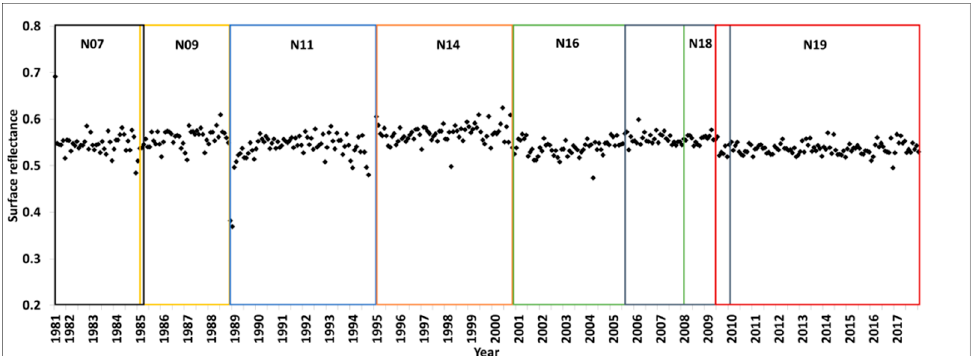
Figure 3. Evolution of near infrared reflectance (channel 2) in the time series. A pixel in the Sahara Desert was selected to better observe the radiometric stability of the different AVHRR sensors, as this area is very stable throughout time [28,29]. In the shift of the different sensors, the greatest instabilities were shown when new versions of the AVHRR sensor were used such as in 2000 with NOAA 16. N07 to N19 indicate the satellite where the AVHRR was mounted, meaning from the NOAA-7 to the NOAA-19 satellites.